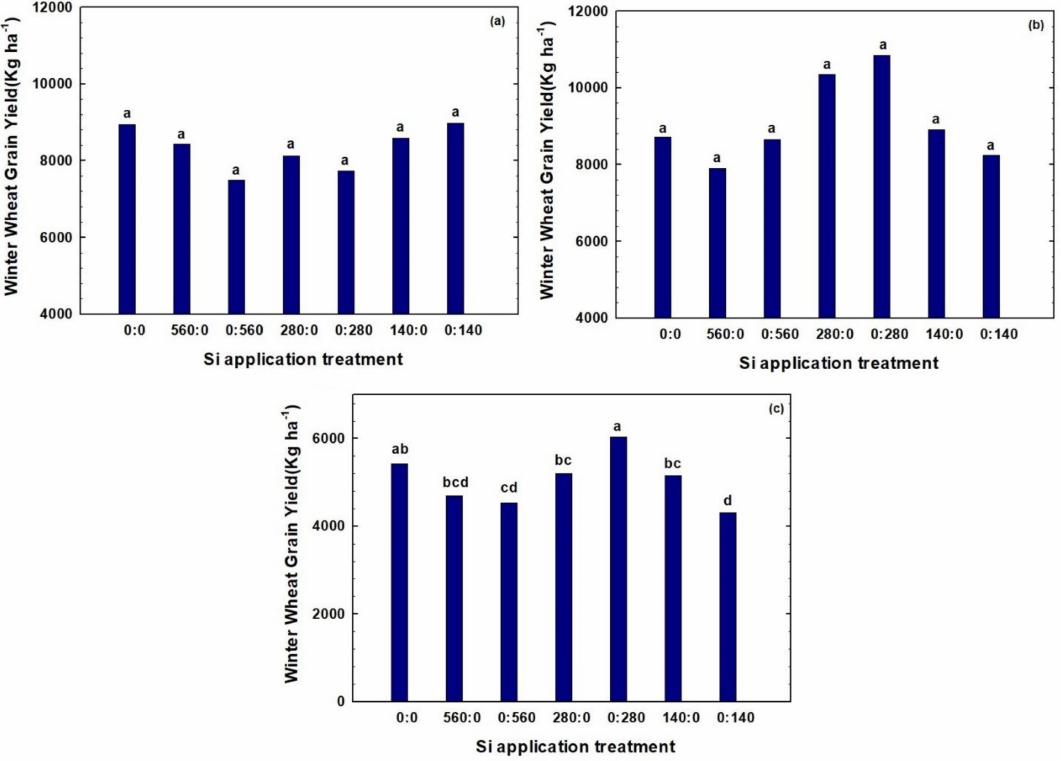
Figure 3. Effect of different Si rates and application time on winter wheat grain yield in ( a ) Field E1 in 2016, ( b ) Field M2 in 2016, and ( c ) Field A3 in 2017. Treatments are designated in the format x:y, in which x and y are the fertilizer Si rates in kg Si ha − 1 applied at planting and at tillering, respectively. Bars within the same year followed by the same letter are not significantly different ( p > 0.1) based on a Duncan’s multiple range